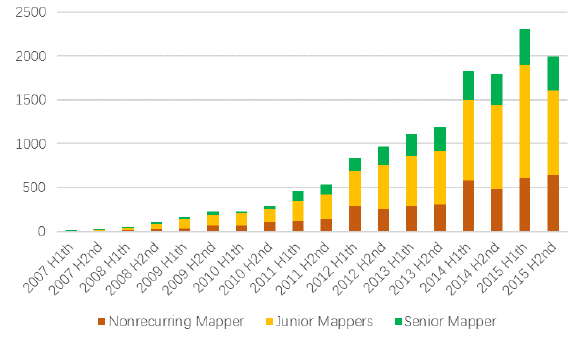
Figure 4. Number of contributors and distribution of mapper groups